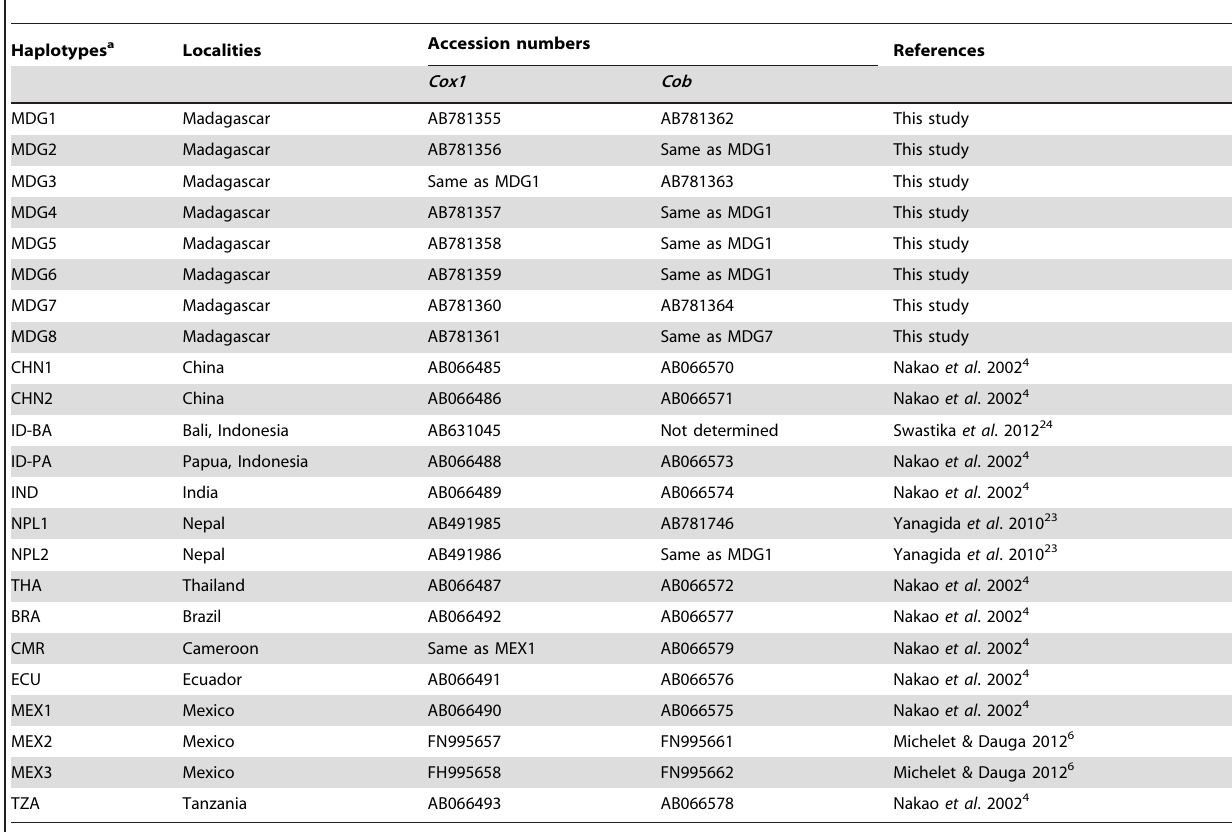
Table 1. Mitochondrial haplotypes of T. solium used for the phylogeographic analysis.